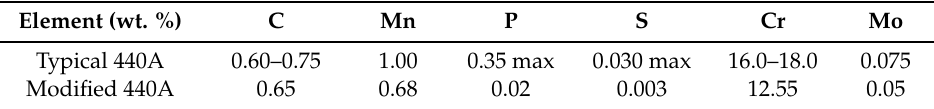
Table 1. Chemical compositions of typical and modified Grade 440A